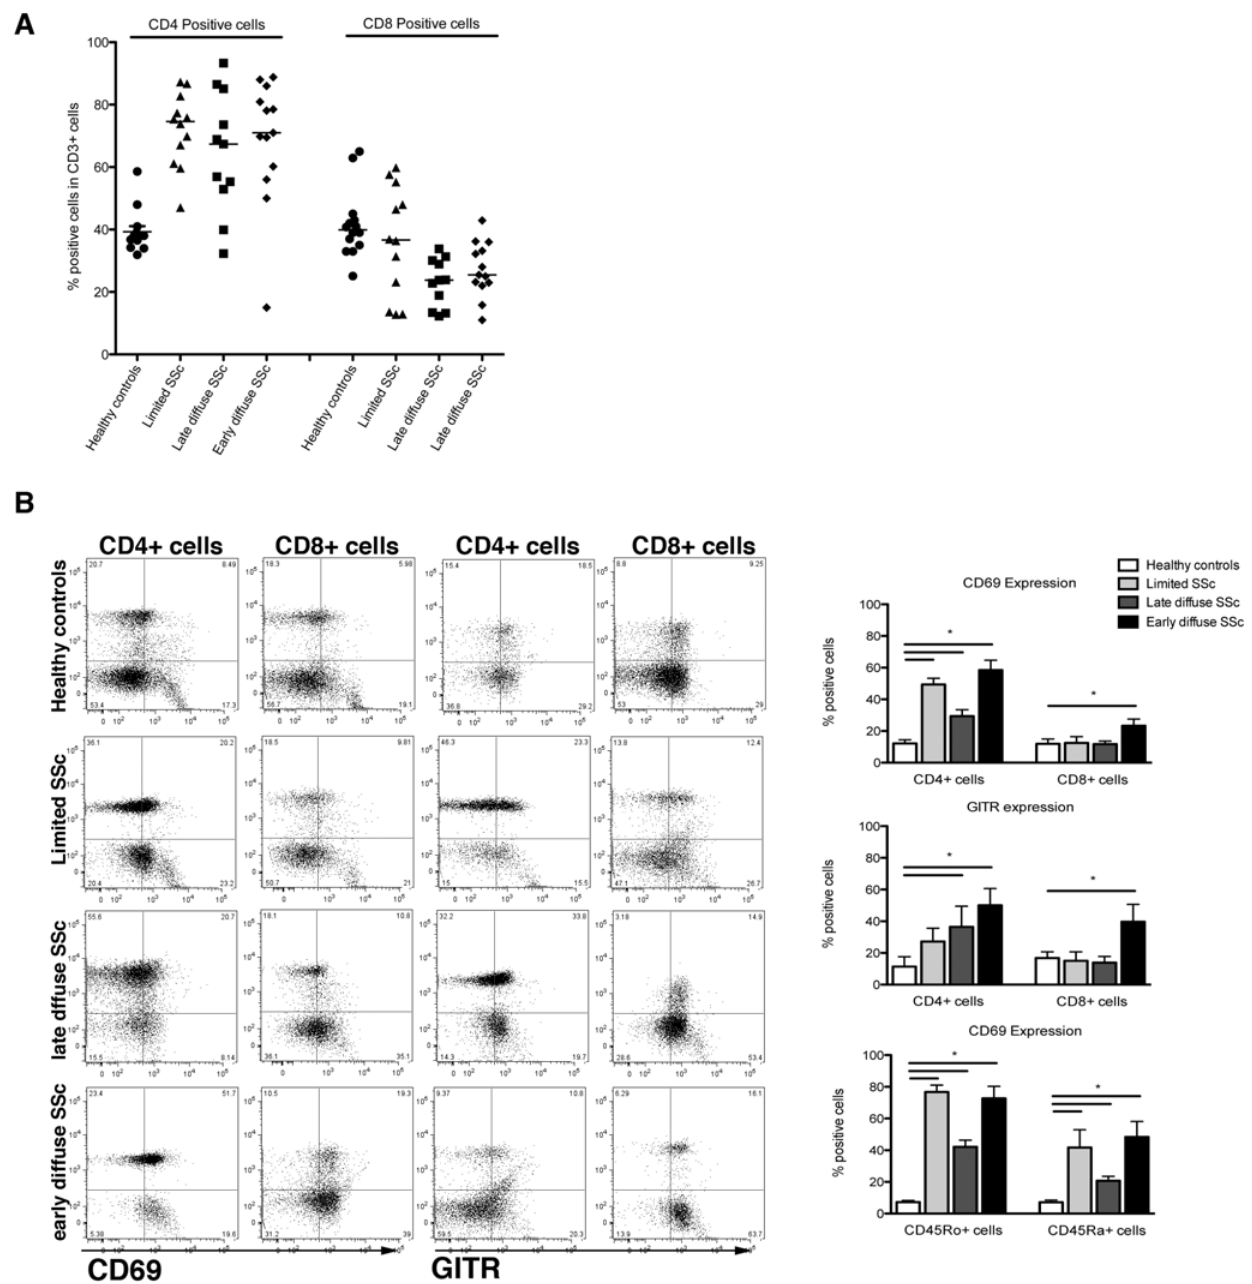
Figure 1. SSc patients have more and more activated CD4 + T cells compared to healthy controls. Panel A depicts the percentage of CD4 + and CD8 + cells in the whole T cell pool (CD3 + cells) from healthy controls (n=14), and SSc patients with the lcSSc (n=12), ldcSSc (n=11) and edcSSc (n=13) phenotype. The CD3 + cells were isolated using MACS bead isolation after which CD4 and CD8 positivity was analyzed using flow cytometry. Panel B (left) depicts the percentage of CD4 + and CD8 + cells that were double-positive for the T cell activation markers CD69 and